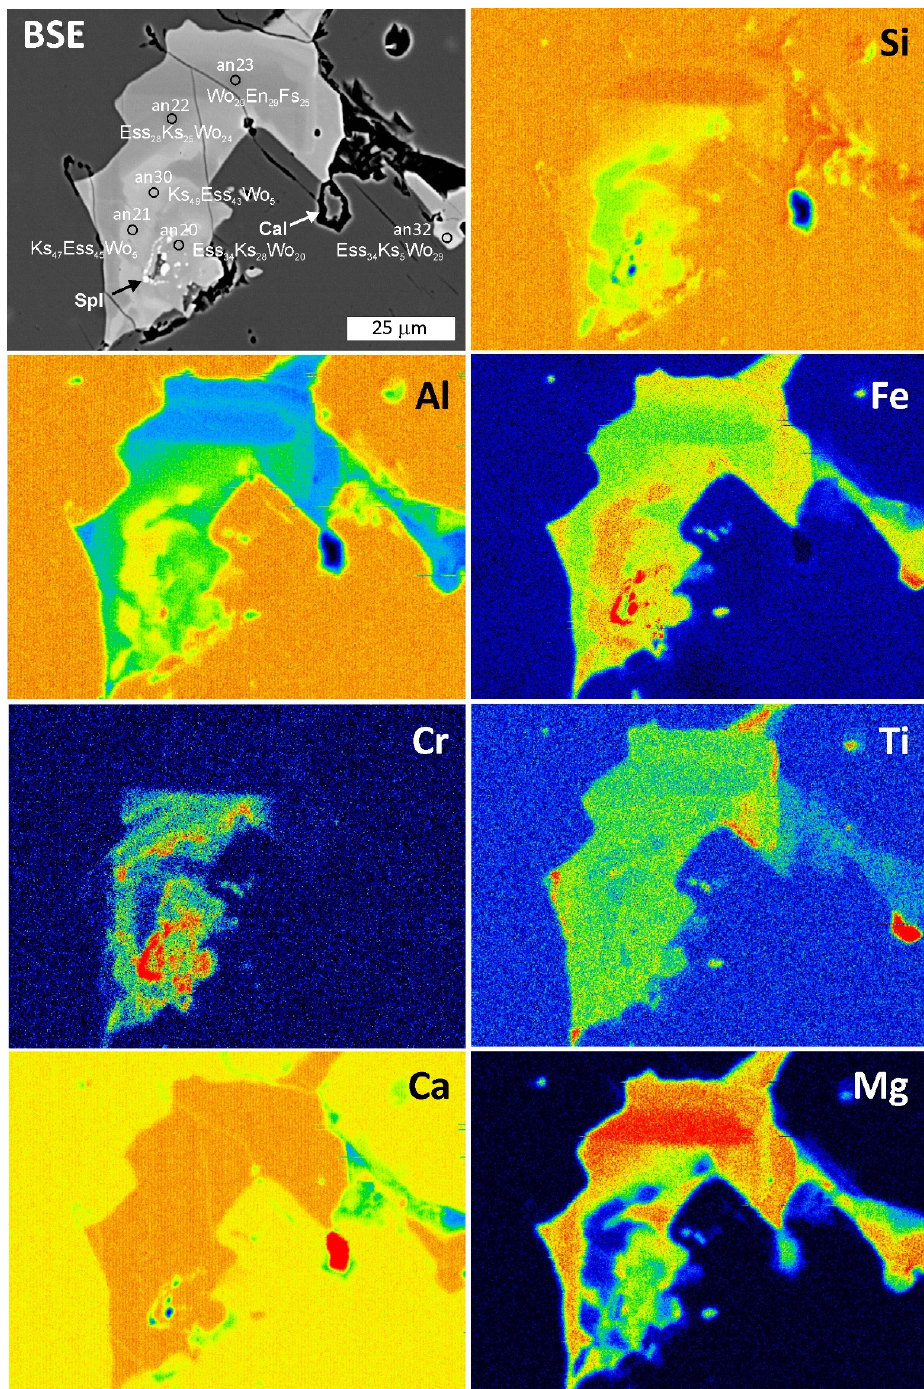
Figure 9. BSE image and false color-coded X-ray maps of esseneite-diopside grain in sample Cam-14. Note locally increased Ti (and V) contents along grain boundaries enriched in Fe and depleted in Al (analysis #32, Table 1). Spinel inclusions are diagnostic of the highest Cr and Fe concentrations. Warmer colors (red, orange) denote higher